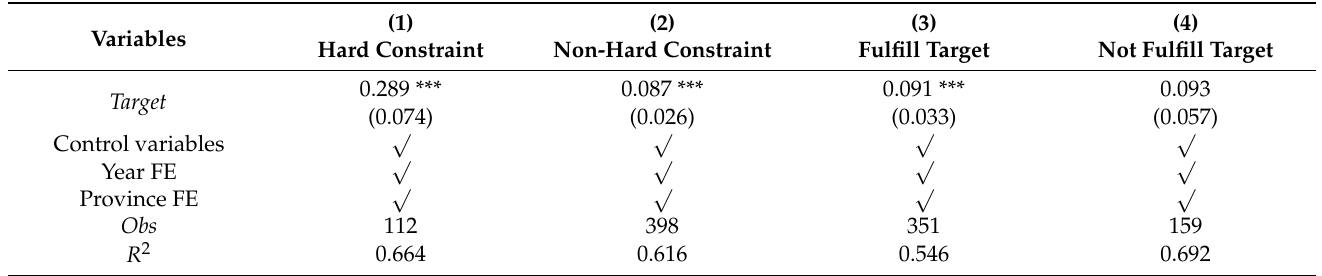
Table 7. Heterogeneity